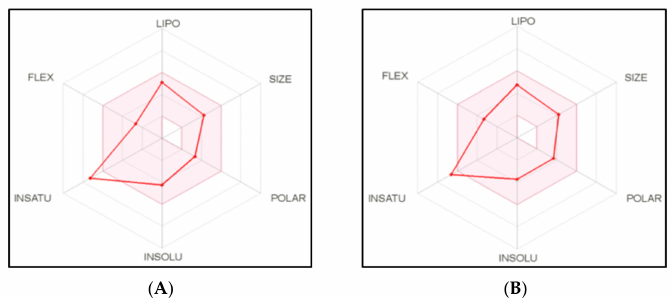
Figure 13. Bioavailability radar chart from Swiss ADME web tool for compounds 4b ( A ) and 4e ( B ). The pink area represents the range of the optimal property values for oral bioavailability and the red lines are the predicted properties of 4b and 4e